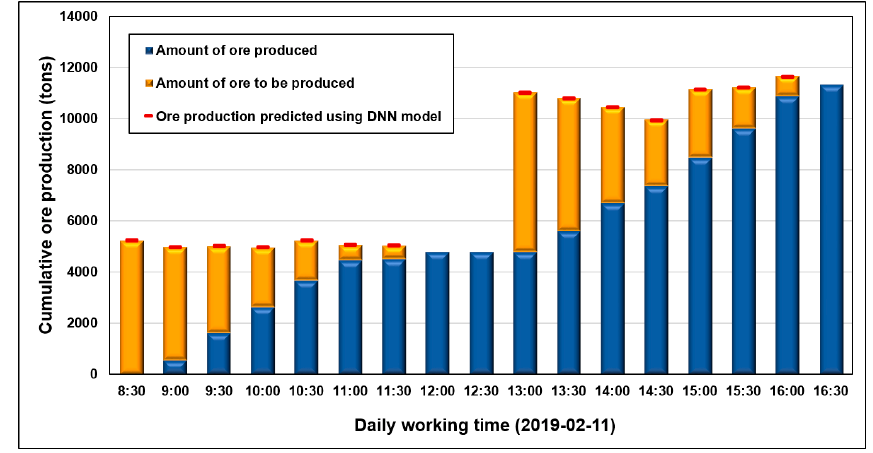
Figure 13. Ore-production predictions performed every 30 min on 11 February, 2019.